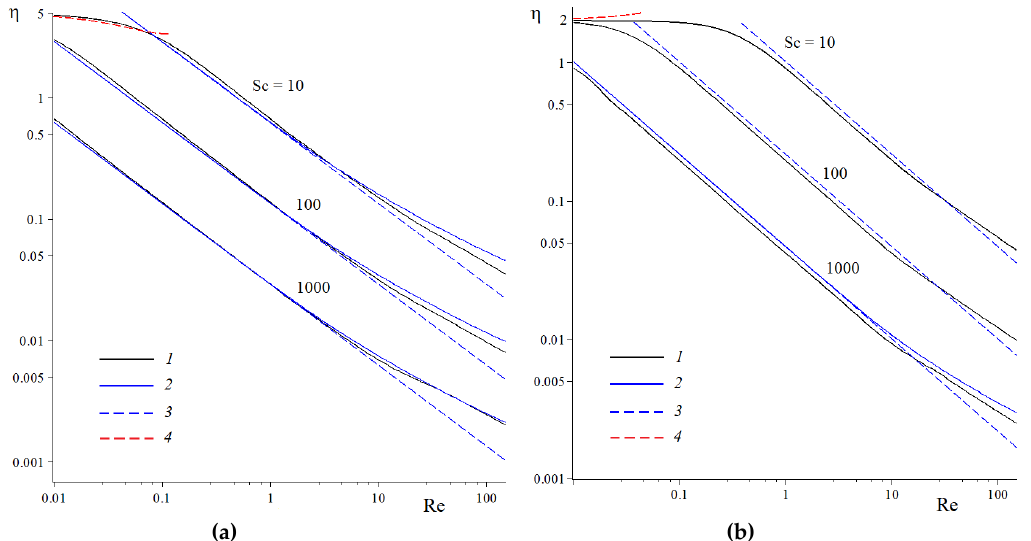
Figure 6. Fiber retention efficiencies per unit length in a row of fibers with different interfiber distances: ( a ) a / h = 0.2 and ( b ) 0.5, vs. Reynolds number, found from the combined numerical solution of the Navier–Stokes and convection–diffusion equations (curves 1 ): Schmidt numbers are marked on the curves. Curves 2 were plotted by Equation (10) with allowance for F = F ( Re ) ; curves 3 were plotted by Equation (10) with F = F 0 for the Stokes flow approximation at Re (cid:28) 1; curves 4 were plotted by the asymptotic formula (Equation (12)) for Pe << 1.